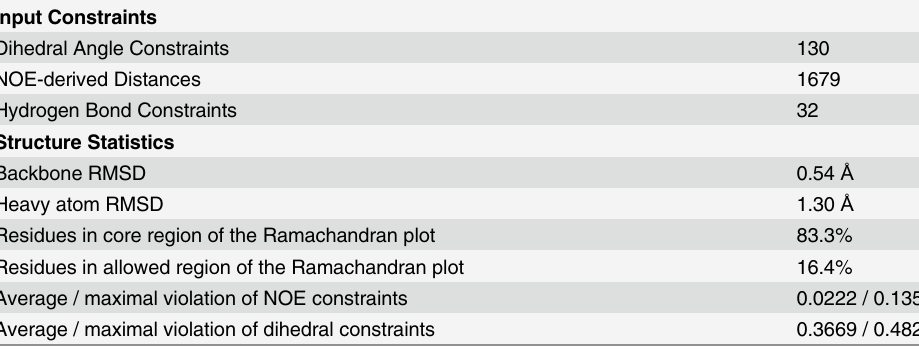
Table 1. Structure calculation statistics of